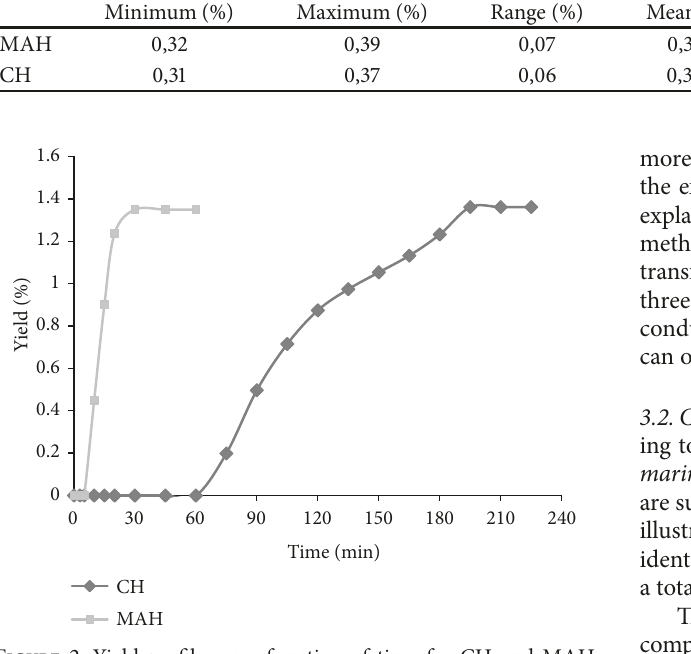
Figure 2: Yield profiles as a function of time for CH and MAH isolations of essential oil from